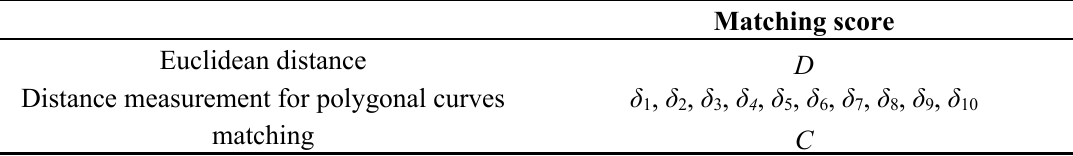
Table 3. The matching